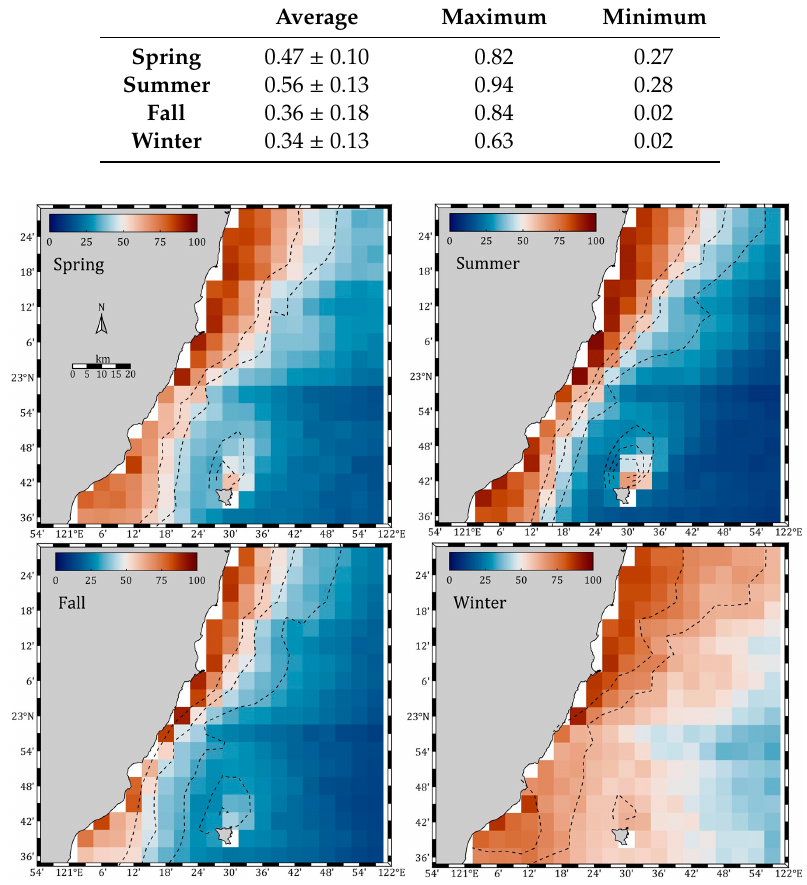
Figure 13. The probability distribution of the Chl-a concentration ( > 0.15 mg/m 3 ) in different seasons.